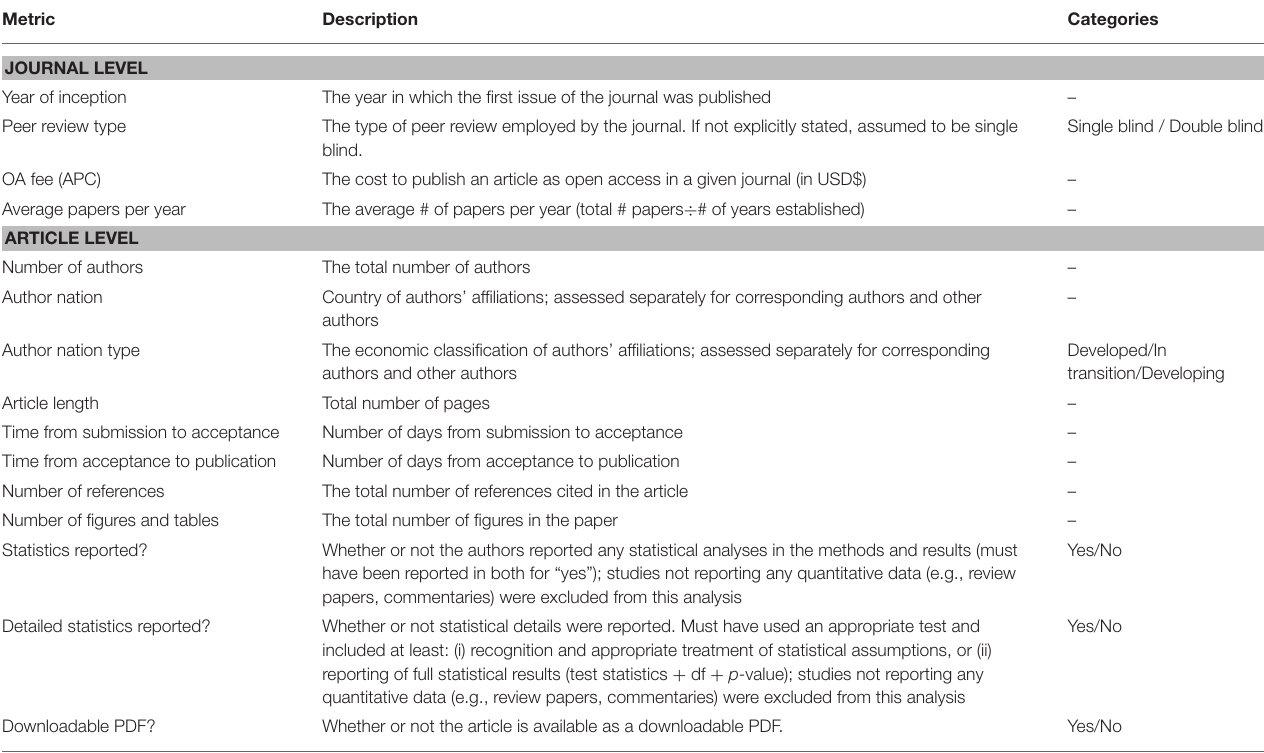
TABLE 1 | Descriptions and associated categories (where applicable) for each journal- and article-level metric